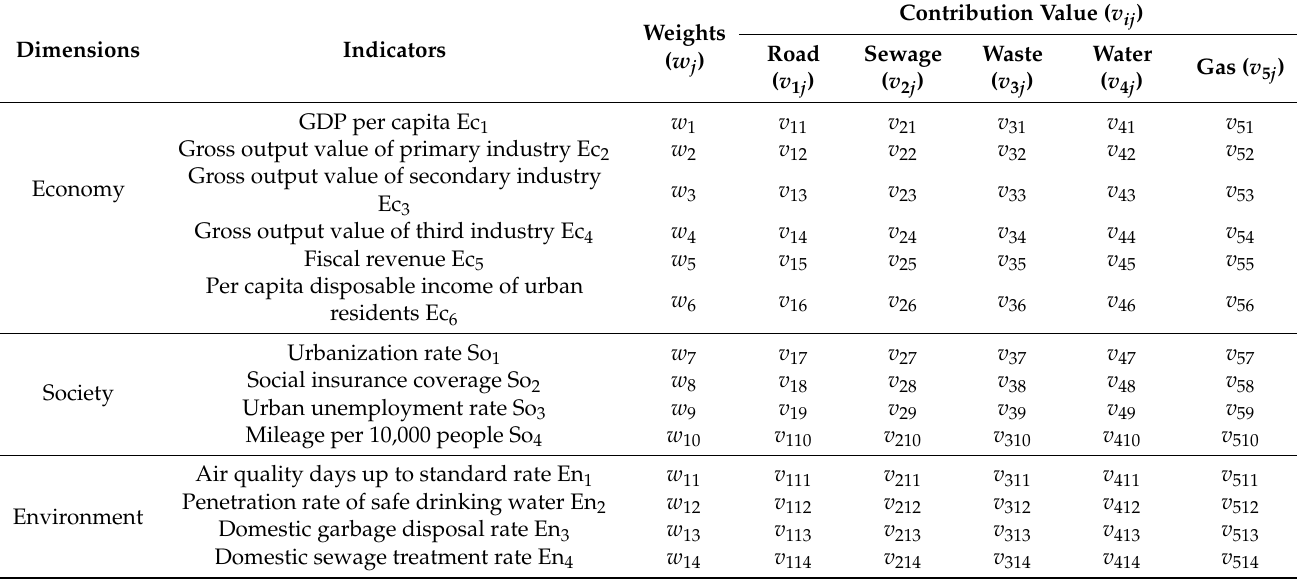
Table 7. Assessment system for sustainable contribution of infrastructure investment in Jian- sheng